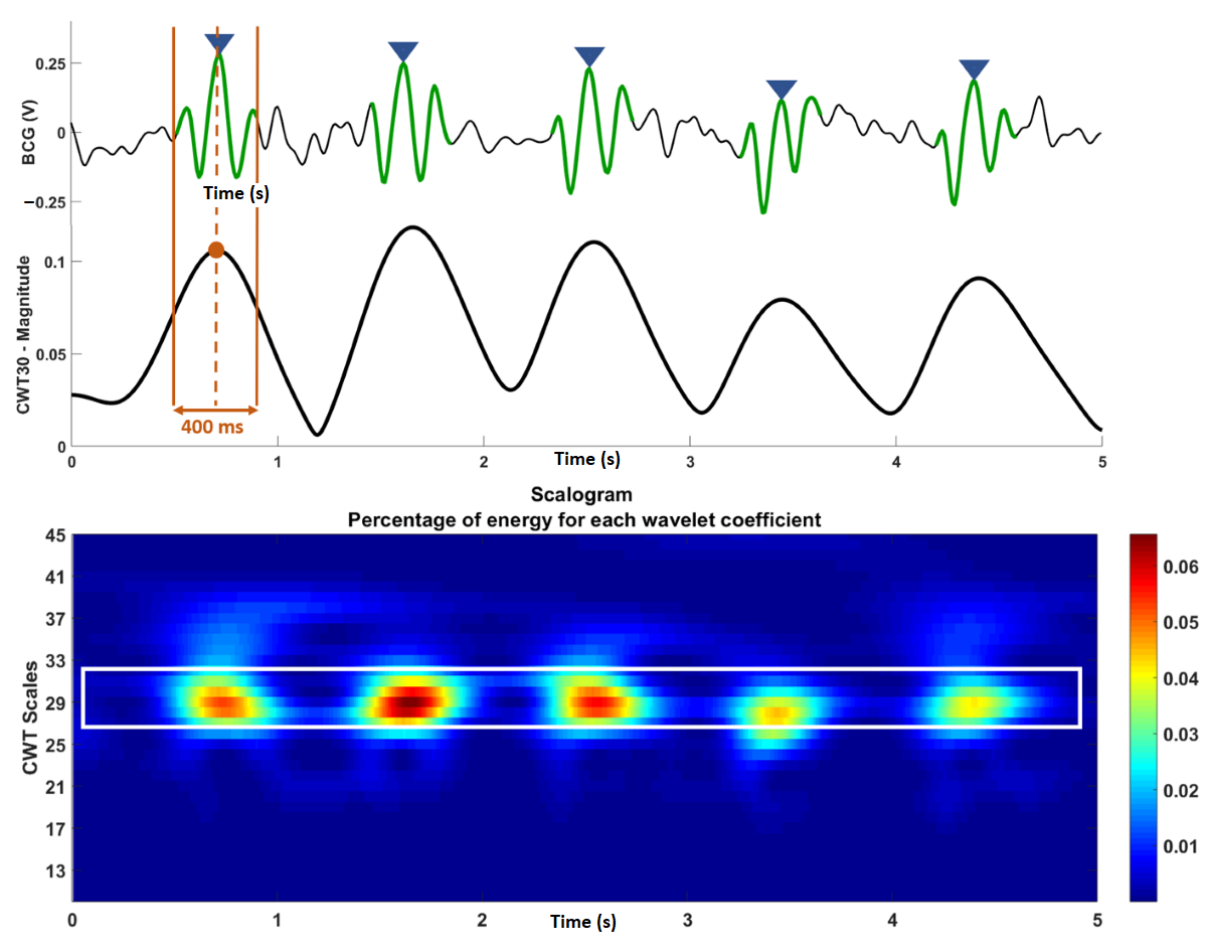
Figure 5. Ballistocardiography (BCG; top) recording with the J-peaks labeled and the continuous wavelet transform (CWT) for the recording with the 400-ms window for heartbeat extraction labeled. Scalogram for CWT of the BCG recording (bottom). BCG: ballistocardiography; CWT: continuous wavelet